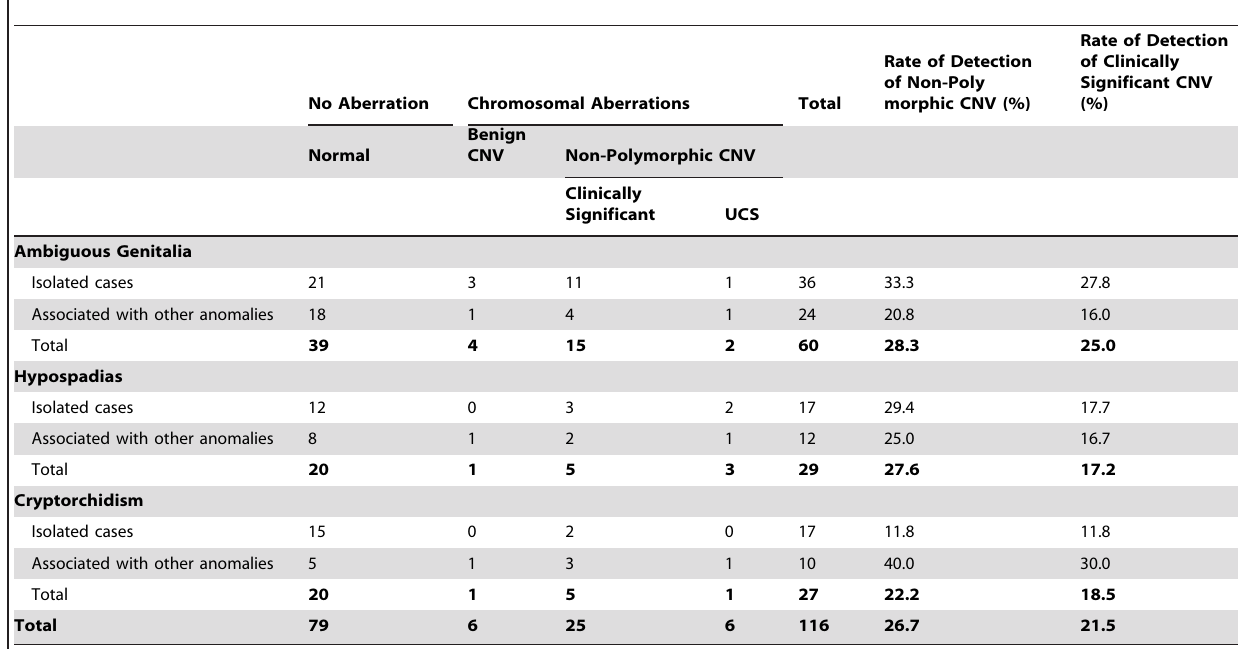
Table 1. Submicroscopic imbalances revealed by CMA screening of children affected with syndromic and non-syndromic disorders of sex